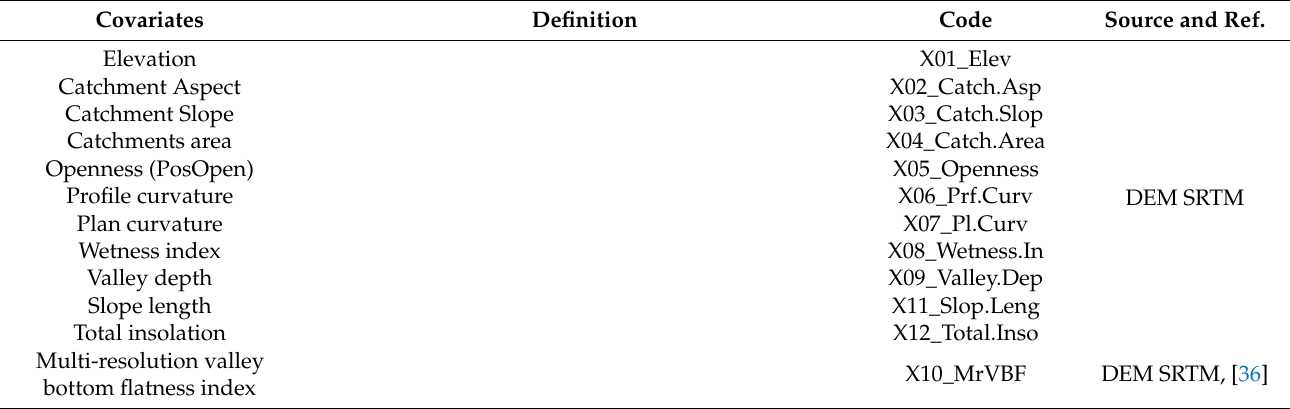
Figure 2. Examples of covariates for the Isfahan province. Table 1. List of environmental covariates used (*L is a canopy background adjustment